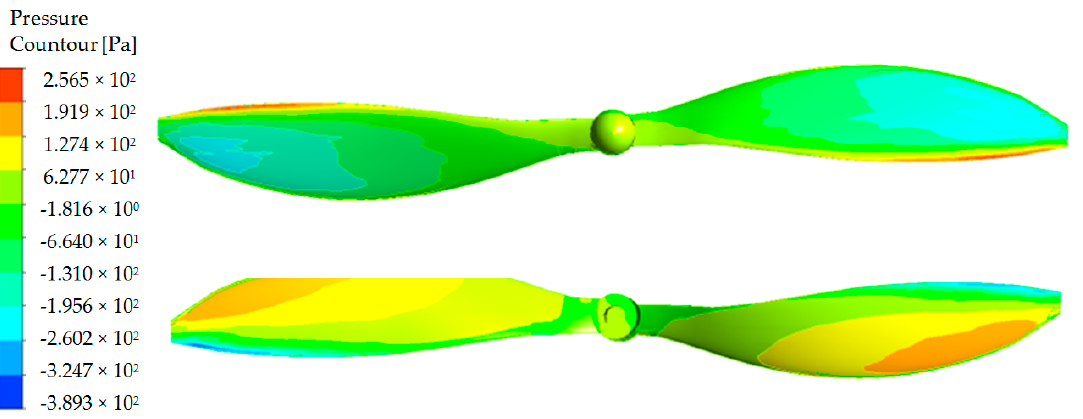
Figure 5. Propeller blade pressure contour for J = 0.628. ( Top ) Front-side of the propeller; ( Bottom ) Back-side of the propeller.